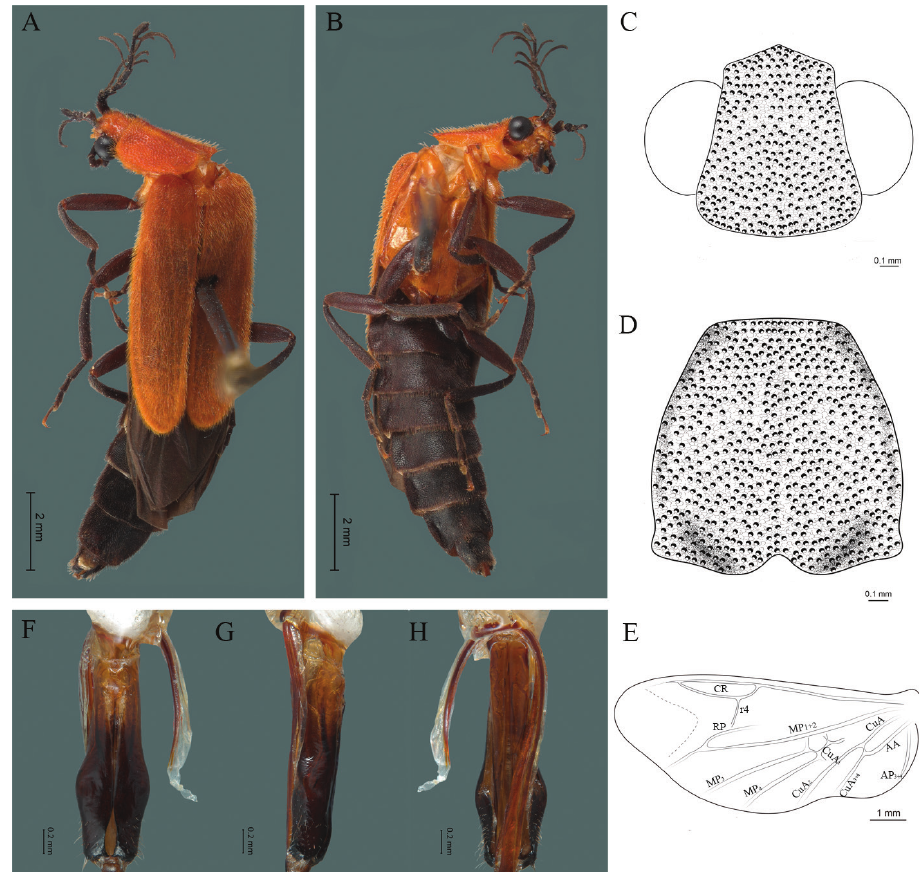
Figure 8. Cenophengus gardunoi Vega-Badillo, Morrone & Zaragoza-Caballero, sp. nov., male. Habitus: A dorsal B ventral C head dorsal D pronotum dorsal E hind wing. Wing venation: CR = Radial Cell; r4 = radial 4 vein; RP = Posterior Radial vein; MP1+2 = Posterior Median vein; CuA = Cubital vein; AA and AP = Anterior and Posterior Anal veins. Aedeagus: F dorsal view G lateral view H ventral